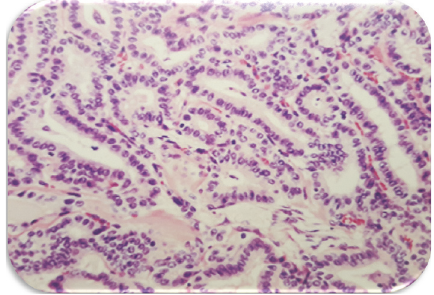
Figure 2: Excisional lymph node biopsy. Metastatic well-differ- entiated papillary thyroid carcinoma in lymph node.